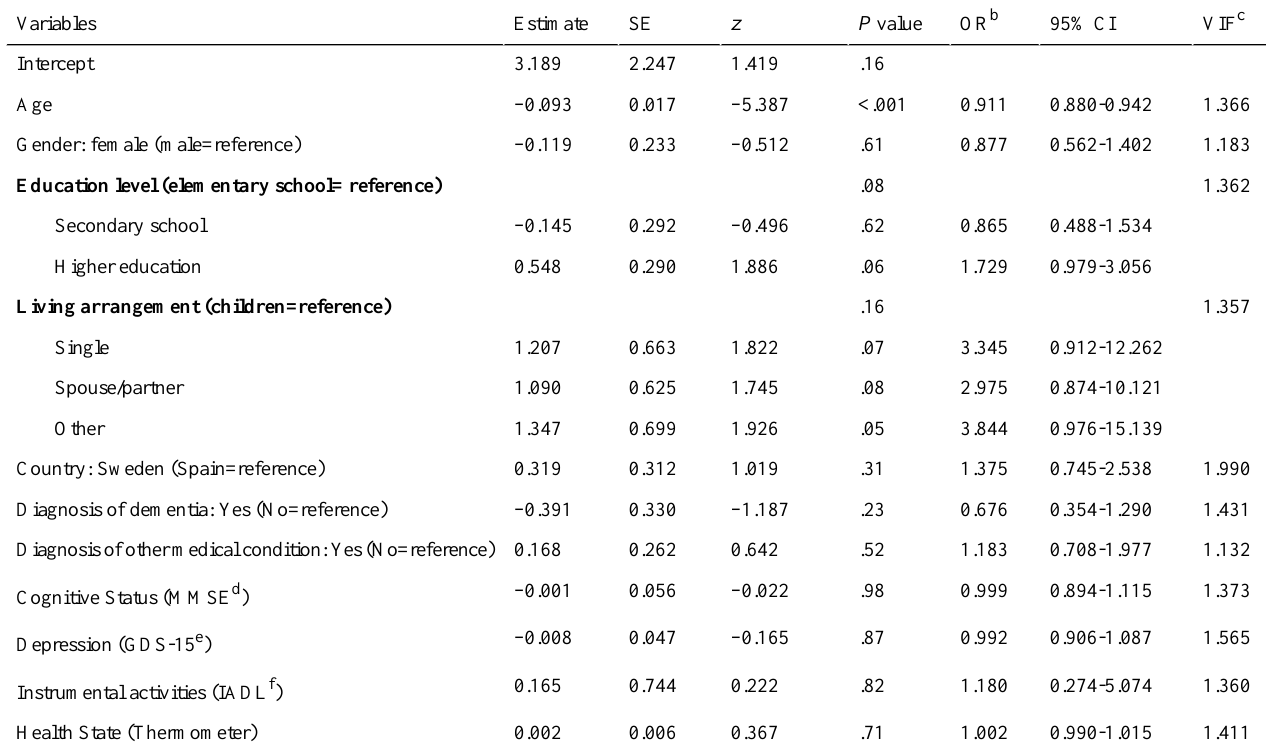
Table 5. Multivariate logistic regression model a of factors associated with use of apps or specific software to support memory in people with dementia/mild cognitive